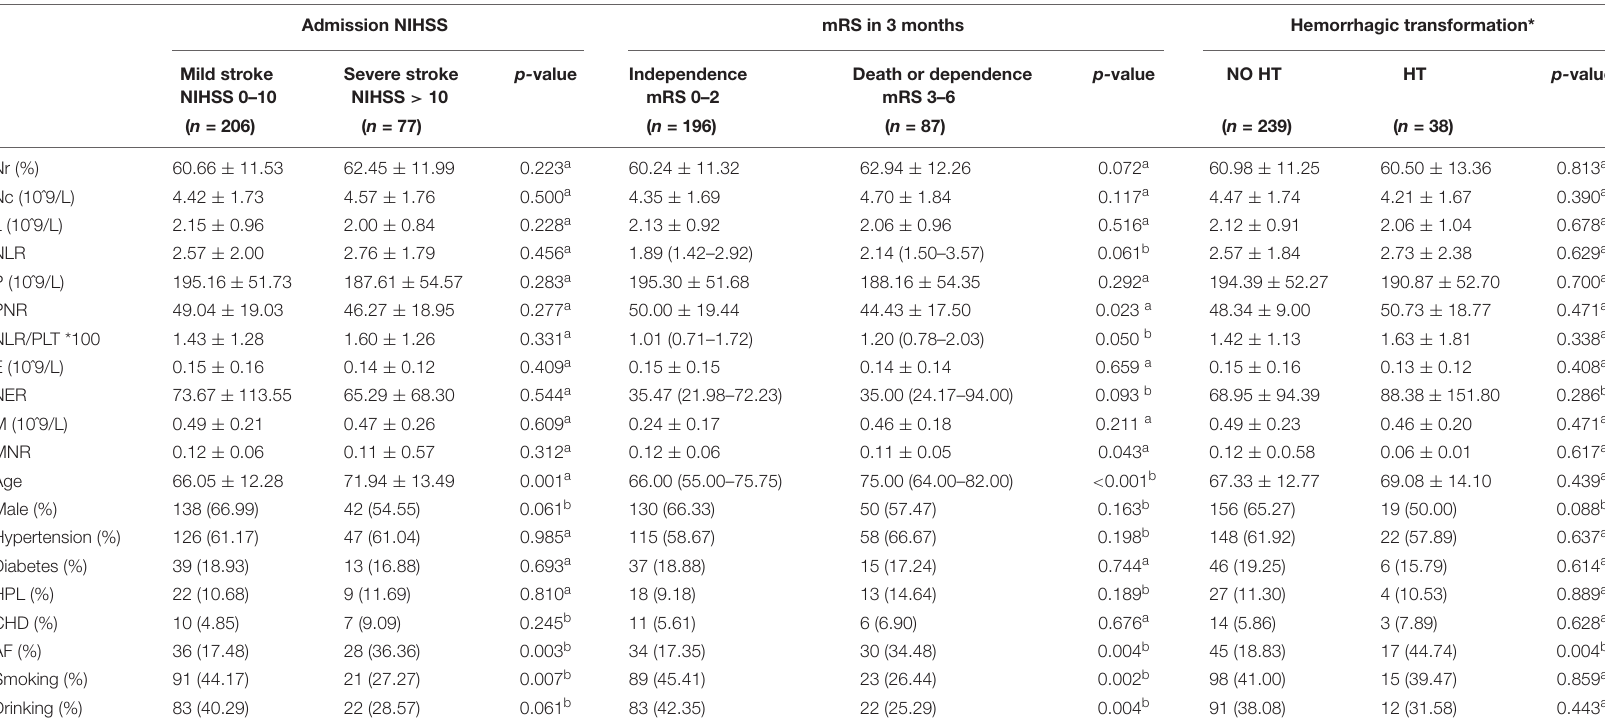
TABLE 2 | Characteristics of the AIS patients on the severity of stroke on admission, outcome at 3 months, and hemorrhagic transformation according to the neutrophil-related